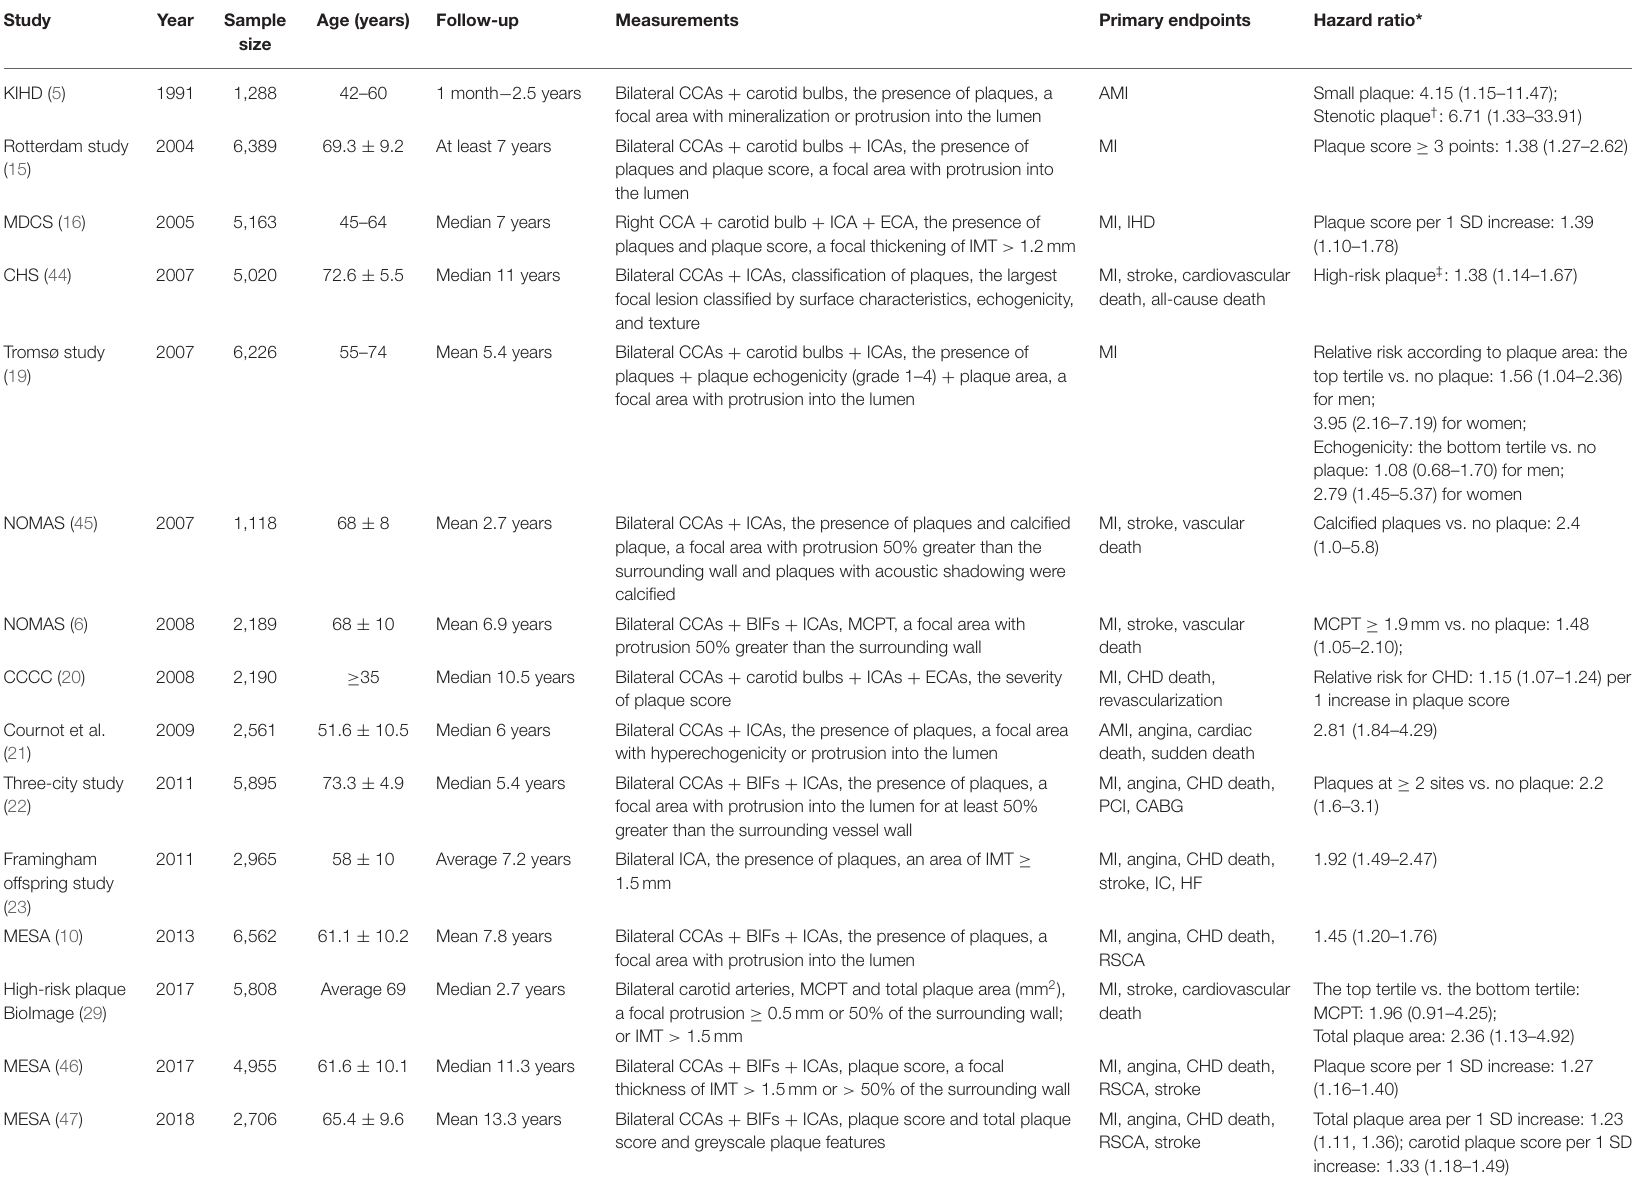
TABLE 2 | Prospective studies with a large general population that assessed the association between carotid plaques and cardiovascular